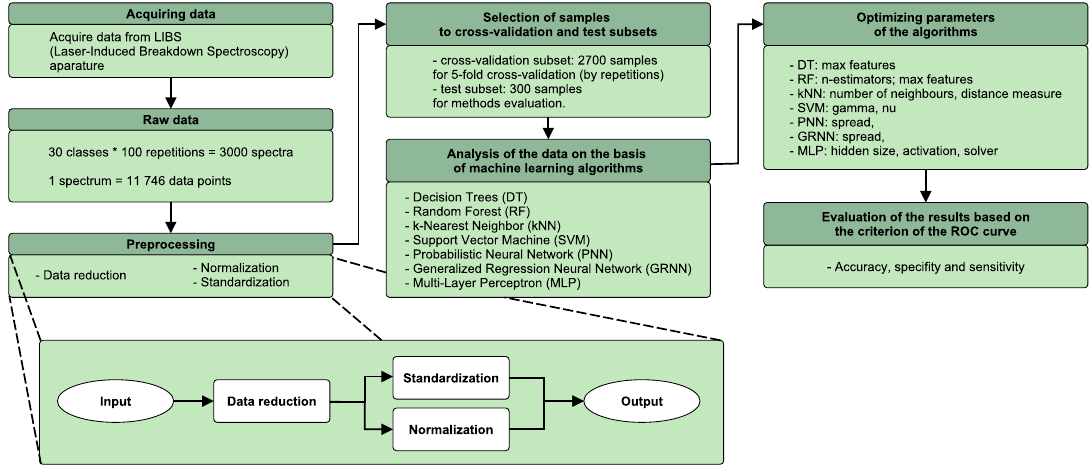
Figure 2. Flow chart of the